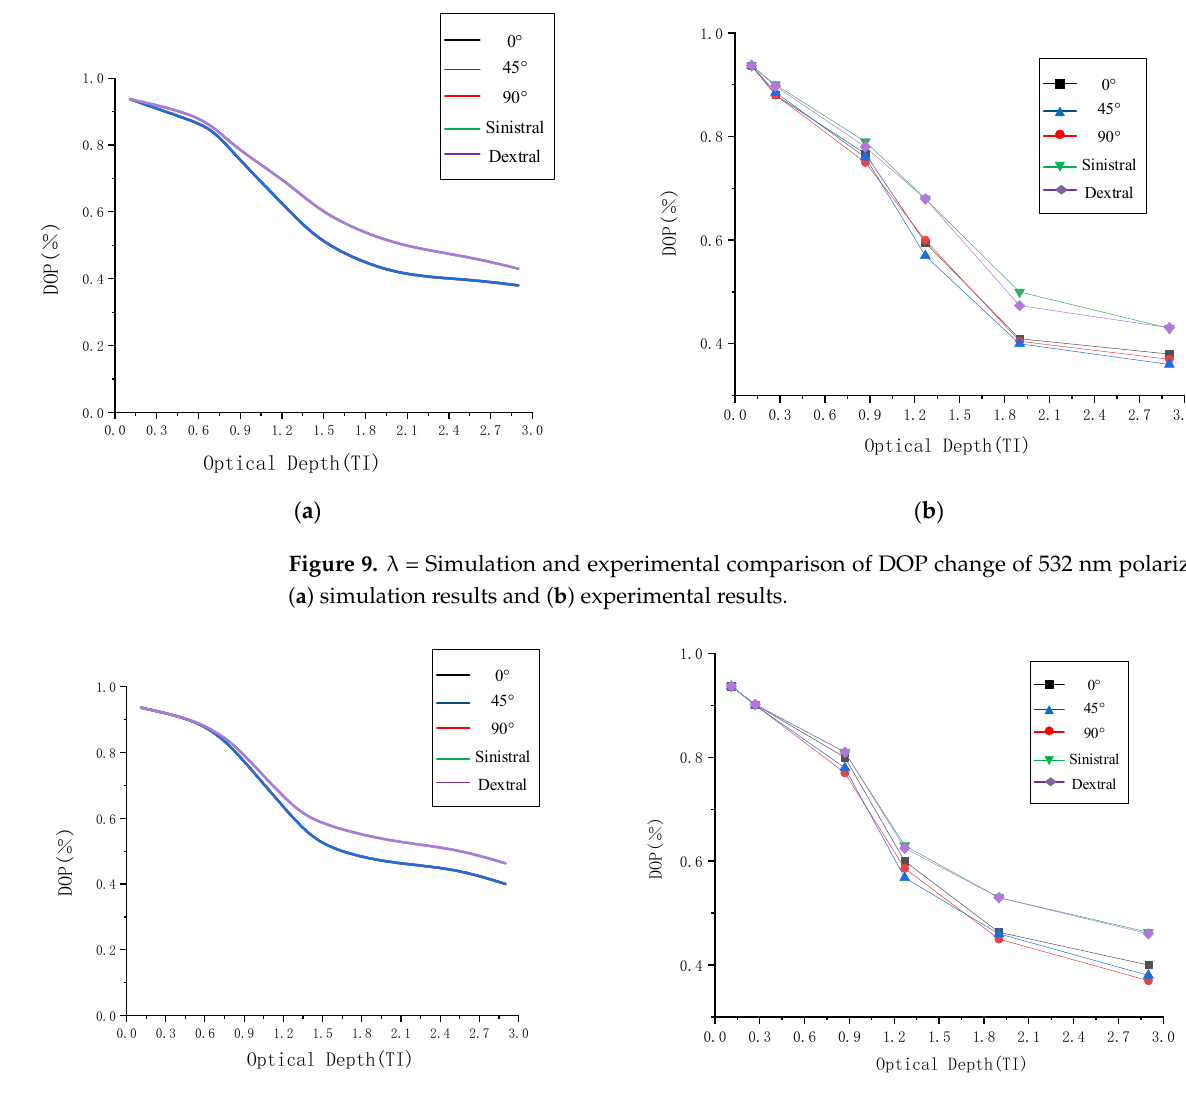
Figure 8. λ = Simulation and experimental comparison of DOP change of 450 nm polarized light: ( a ) simulation results and ( b ) experimental results.